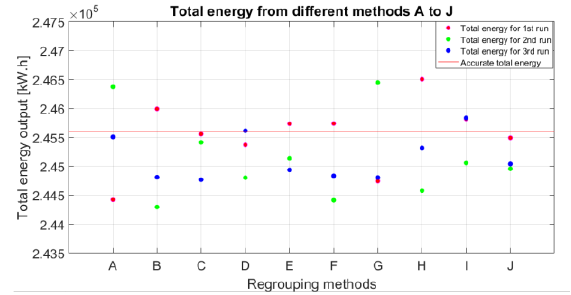
Fig. 13. Total energy estimation from methods A to